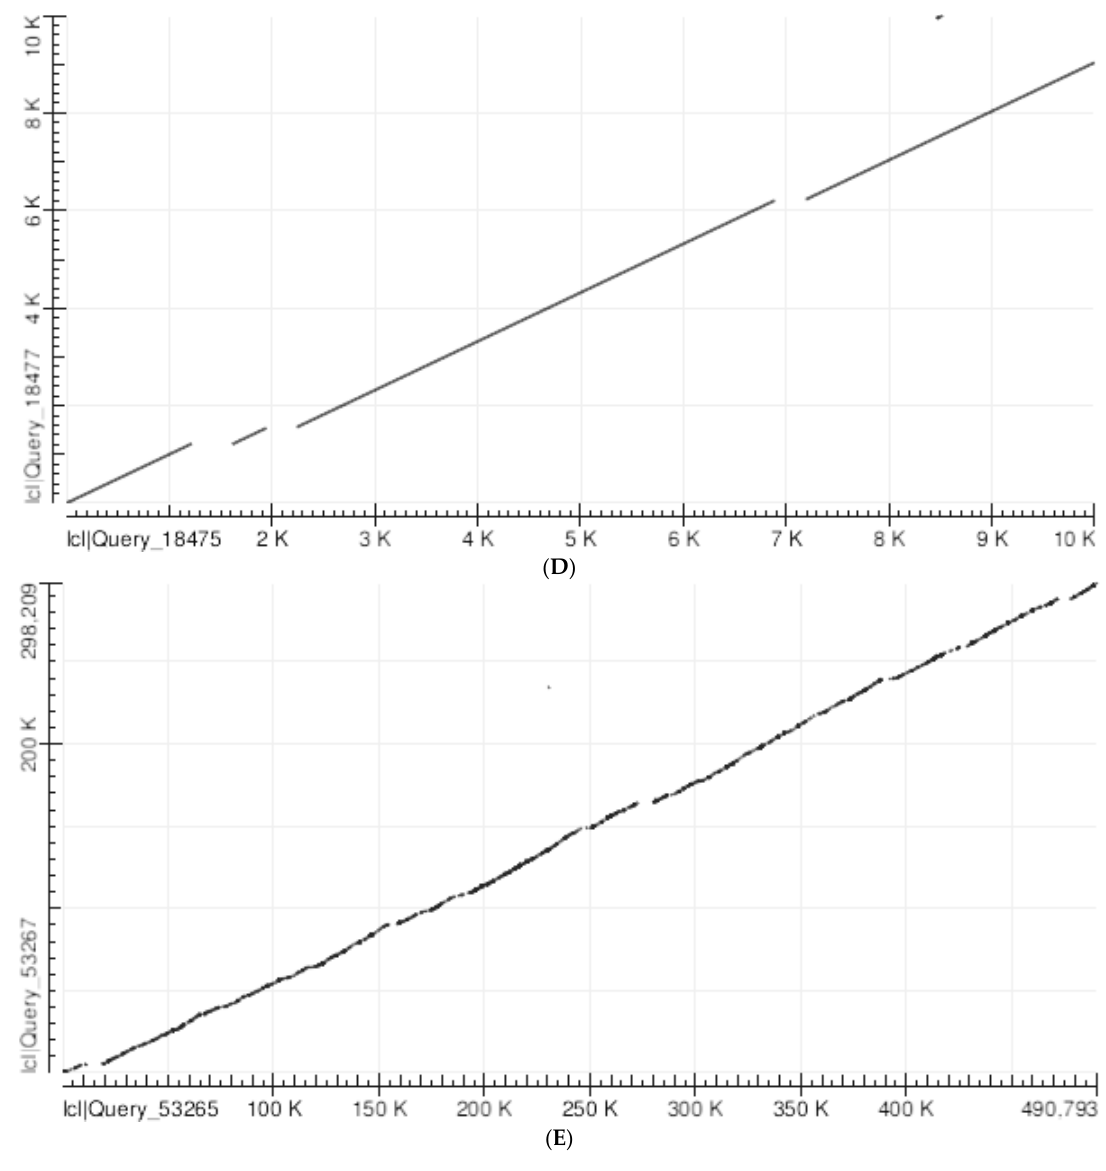
Figure 1. ( A ) Abscissa: Human SLC25A21 (490,793 nucleotides; the sequence from start to stop codons after removal of exons). Ordinate: the same sequence as in the Abscissa. Number of matches: 7704. Note the perfect alignment along the diagonal from the lower left corner to the upper right corner and the large number of matches outside the diagonal. ( B ) Abscissa: Human GHR (292,898 nucleotides; the sequence from start to stop codons after removal of exons). Ordinate: the same sequence as in the Abscissa. Number of matches: 1840. Note the perfect alignment along the diagonal from the lower left corner to the upper right corner and the large number of matches outside the diagonal. ( C ) Abscissa: Human SLC25A21 (490,793 nucleotides). Ordinate: Human SLC25A21 after removal of all the 130 SINE Alu s (462,572 nucleotides). Number of matches: 3220 (compared with A ). Note the seemingly perfect alignment along the diagonal from the lower left corner to the upper right corner. ( D ) A partial, magnified, view of panel ( C ), showing a 10 K per 10 K area from the lower left corner, magnified by 50 × . The gaps correspond to the removed SINE Alu s. ( E ) Abscissa: Human SLC25A21 (490,793 nucleotides). Ordinate: Human SLC25A21 after removal of all TEs (298,209 nucleotides). These additional TEs belong to different categories, and some of them are much larger than the SINE Alu s. Number of matches: 505. Note that the gaps (due to TEs) along the diagonal from the lower left corner to the upper right corner are now more visible at low